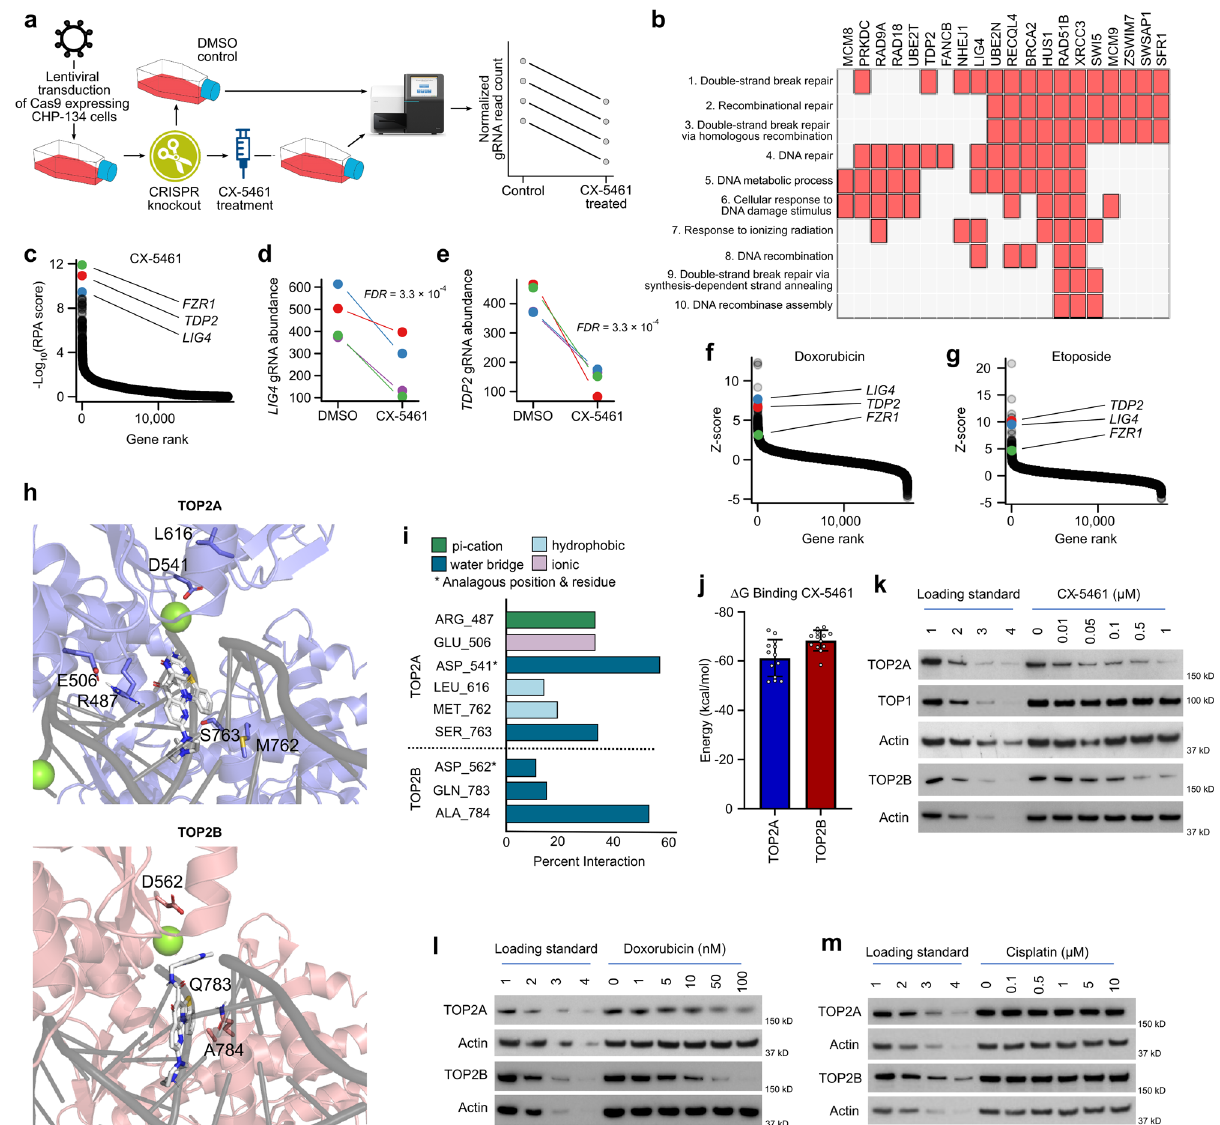
Fig. 2 CX-5461 is a topoisomerase II inhibitor. a Schematic of CRISPR knockout screening strategy. b Clustergram generated by Enrichr showing the assignment of statistically signi fi cant (red boxes) gene knockouts to the most highly enriched GO (2018) Biological Processes. Genes with an FDR < 0.05 ( n = 40) were used as input. c Top hits in our genome-wide CRISPR knockout screen in CHP-134 cells. Genes are ranked by -log 10 (RPA score). d Relative abundance of 4 independent LIG4 guide RNAs in our CRISPR screen. e Like ( d ) but for TDP2 . f Waterfall plot summarizing CRISPR knockout screening data obtained from Oliveri et al. Higher values on the y -axes imply that knockout has sensitized cells to doxorubicin. TDP2, LIG4 , and FZR1 are highlighted. g Like ( f ) but results shown for the topoisomerase II inhibitor etoposide. h Representative poses from equilibrated molecular dynamics simulations of CX-5461 bound to TOP2A (top) or TOP2B (bottom). DNA strands are shown in gray. CX-5461 is displayed in white, and its heteroatoms colored blue (nitrogen), red (oxygen), and sulfur (yellow). Green represents magnesium ions. i Percentage of CX-5461 interactions with TOP2A or TOP2B in simulations. Residues interacting with either protein are listed if they conferred ≥ 10% interaction with CX-5461. Bar colors correspond to the type of interaction. (*) indicates residues in the same position when the two proteins are superimposed. j Weighted average of the relative binding af fi nity for CX-5461 is plotted for TOP2A and TOP2B. Data represent mean ± SD of n = 13 independent weighted simulation clusters (described in “ Methods ” ). P = 0.01 from two-sided t-test. The source data are included in Source data fi le. Band-depletion assay for CX-5461 ( k ), doxorubicin ( l ), and cisplatin ( m ) treated CHP-134 cells. For lanes 1 − 4, protein equal to 33, 16.5, 8.3, and 4.1 thousand untreated cells were loaded respectively. For each of the rest of the lanes, protein equal to 33 thousand cells was loaded. Representative results of three biological replicates are gel electrophoresis (comet) assay in CHP-134 cells treated with 0.2 µM CX-5461 for 30 min or 24 h, with DNA damage evident at